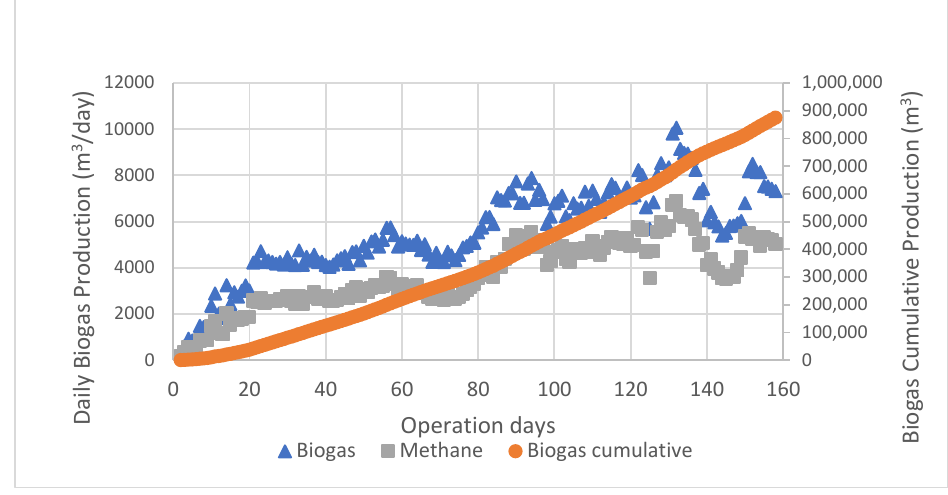
Figure 11. Biogas production.